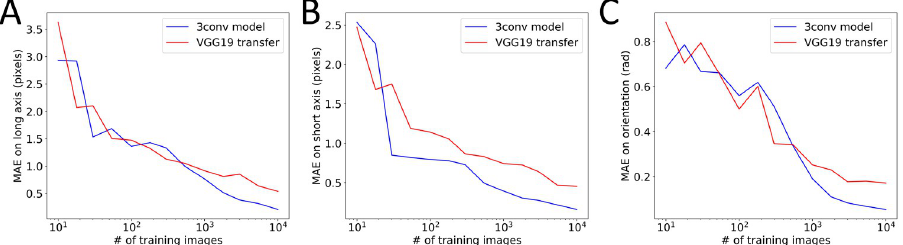
Fig 8. Effect of training set size. Performance of either the best 3-conv model (blue) or transfer from VGG19 (red) as a function of the number of images used in their training. MAE is shown for long axis (A), short axis (B) and orientation